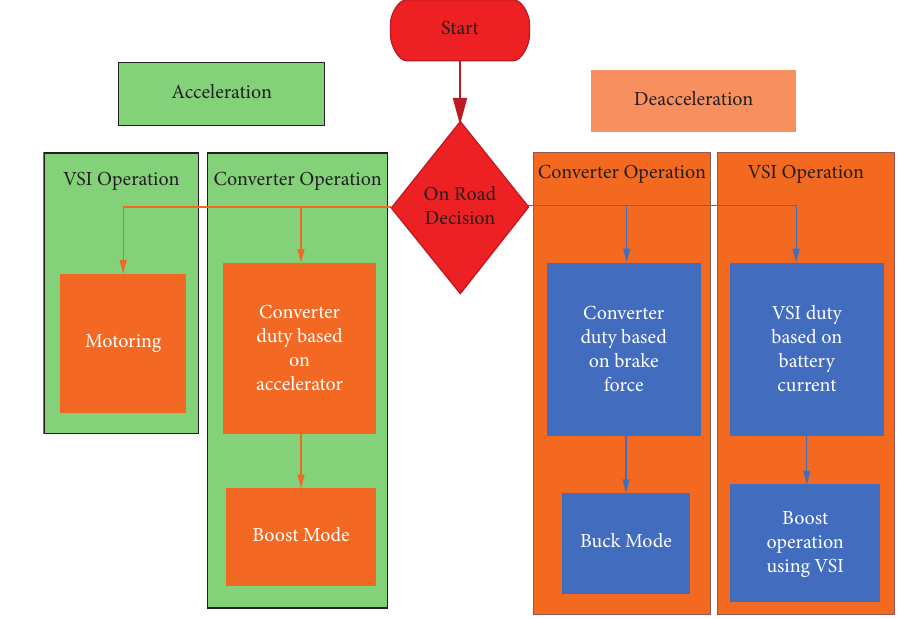
Figure 9: Flow diagram of the converter operation in EV.